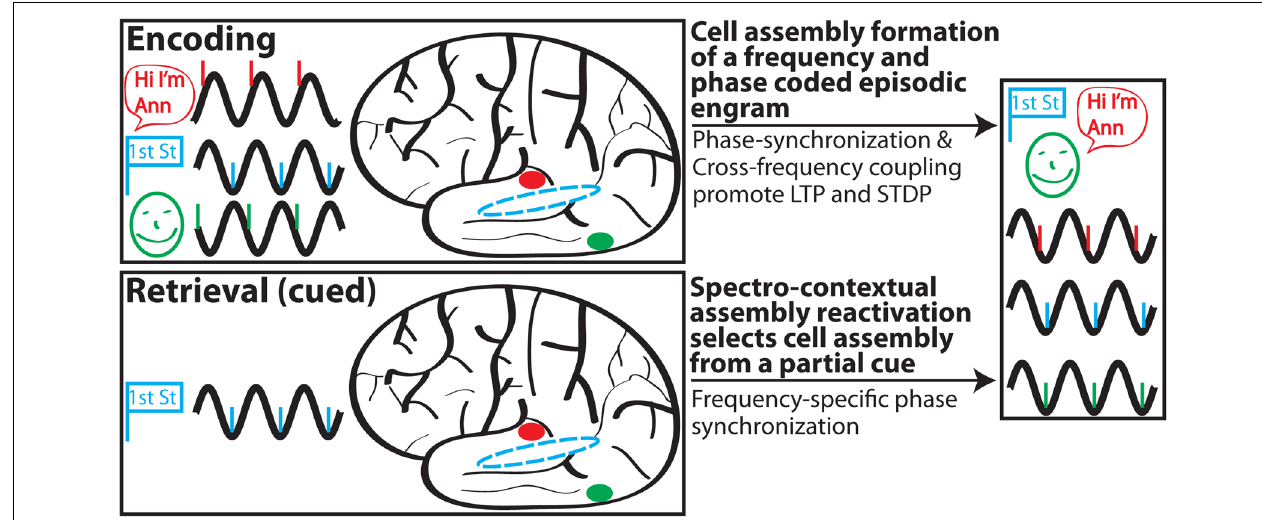
following learning. Episodic encoding is associated with phase synchronization between areas and CFC between assemblies representing different aspects of the experience. During retrieval, a partial cue (encountering first street) initially drives hippocampal activity to reinstate the spectral signature associated with the encoding experience. Note that some aspects of SCERT, including neuronal resonance and frequency multiplexing, are not